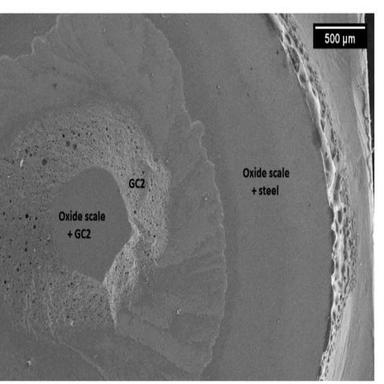
(a) anomalous fracture surfaces after torsion for some THG-5 GC2 joined sample tested at room temperature: (b) fracture propagation sketch (orange = glassceramic; grey = oxide scale; red = fracture propagation) with GC2 present mostly on one fracture surface, as observed by SEM-EDS in (c) with each region identified (For interpretation of the references to colour in this figure legend, the reader is referred to the web version of this article.).